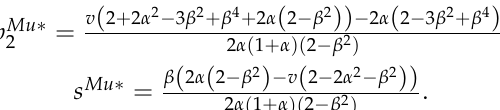
and β Fu Fu β and 1 1